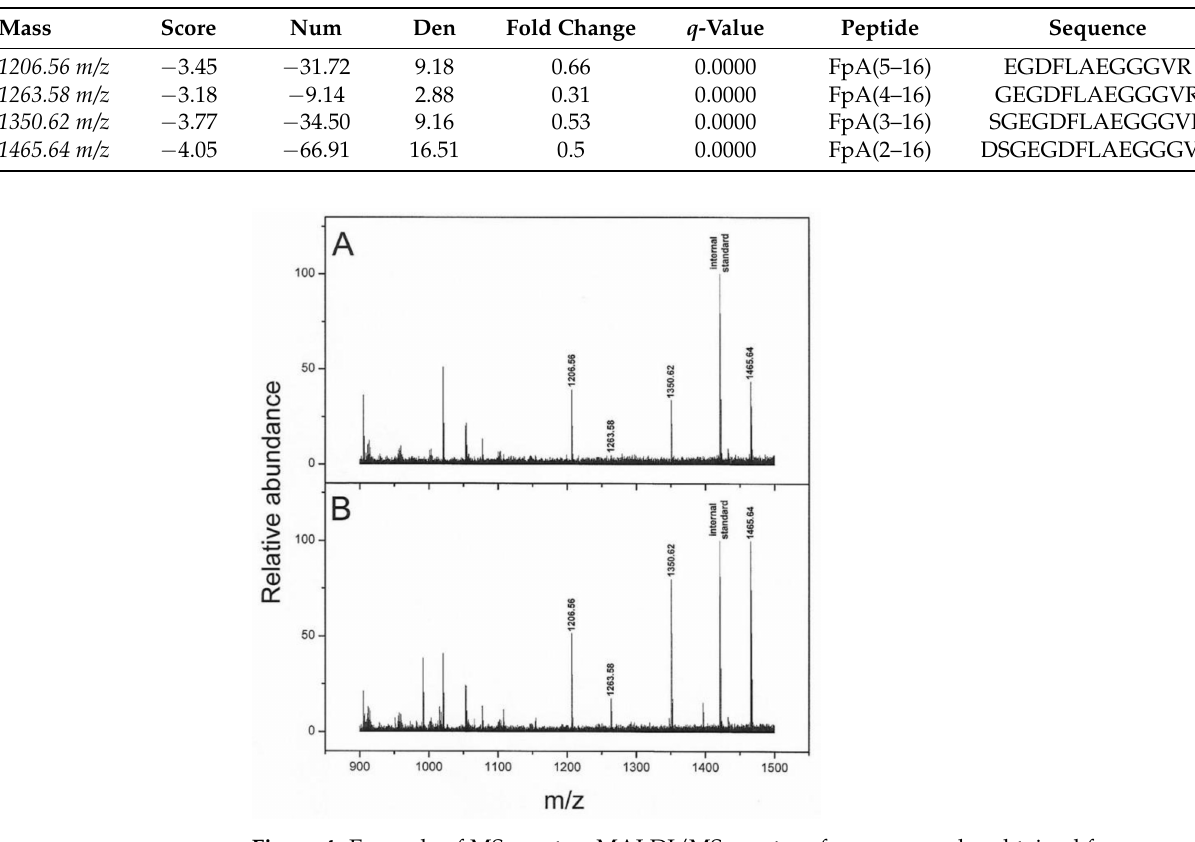
Figure 4. Example of MS spectra. MALDI/MS spectra of serum samples obtained from recurrent ( A ) and non-recurrent ( B ) NSCLC patients. The FpA-derived fragments and the internal standard (at 1420.76 m/z) are labelled with mono-isotopic m/z value. The more preserved forms of FpA are reduced in the serum sample from recurrent patient. Abbreviation: is: Internal Standard.